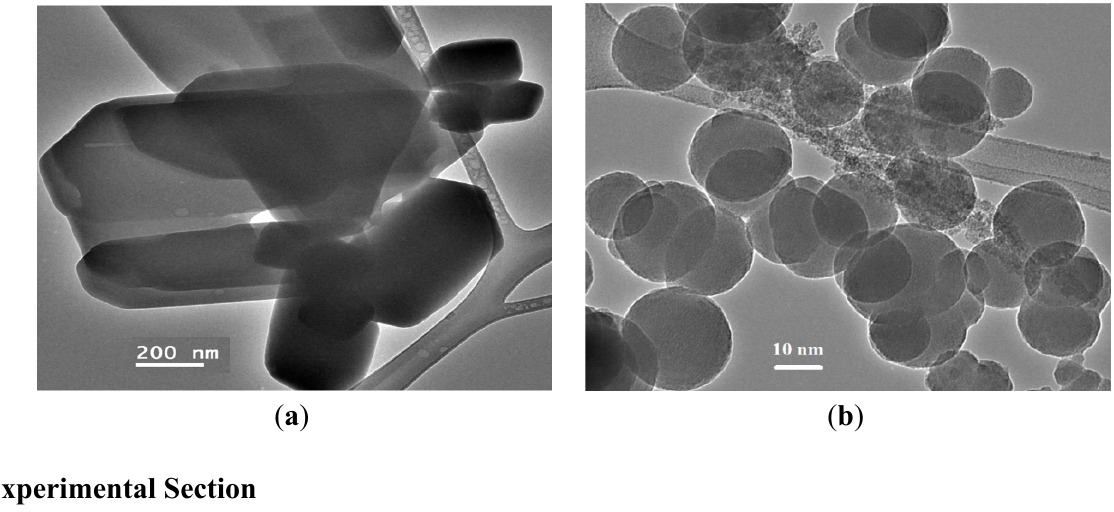
Figure 9. TEM micrographs ( a ) NiCl and ( b ) NiO